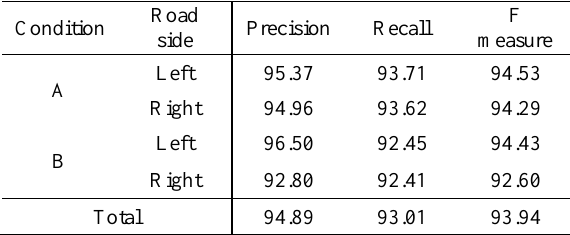
Table 3. Quantitative evaluation of curb detection